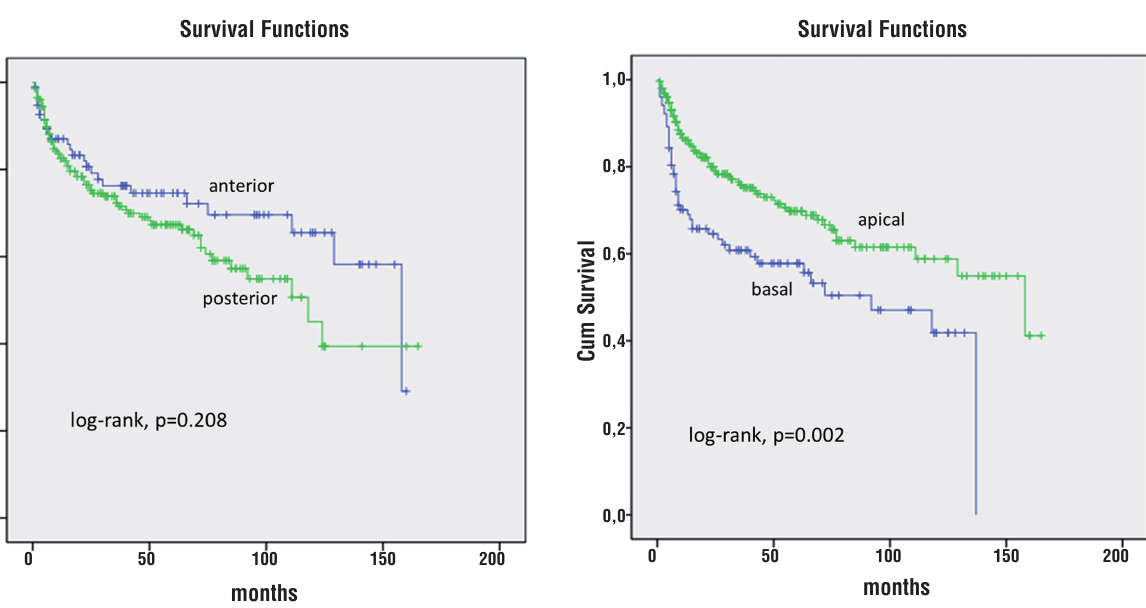
figure 3 - Kaplan-Meier product limit analysis shows time to psA biochemical progression-free outcome by index tumor basal vs apical predominant location. cum, cumulative.